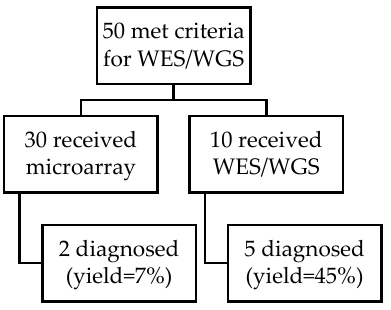
Figure 2. Although more neonates had FISH and/or microarray testing than WES/WGS in our cohort, the yield of microarray was much lower. The yield of microarray was 7% and the yield of WES/WGS was 45%.